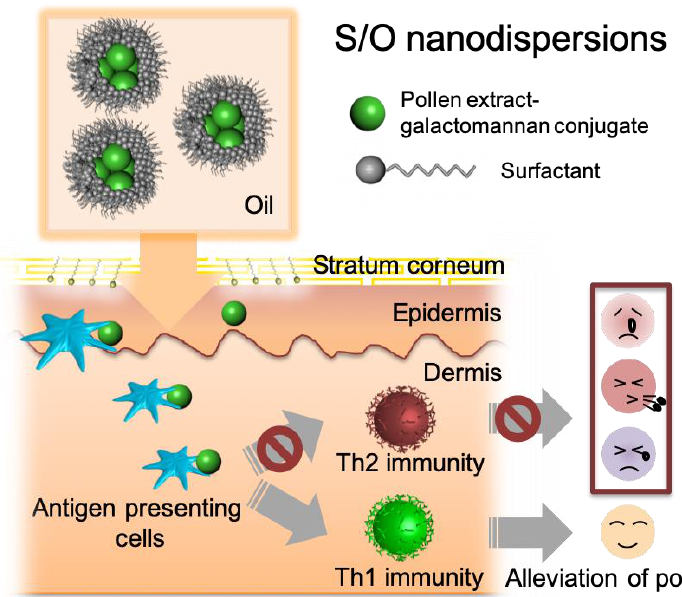
Figure 1. Graphical abstract of this study.